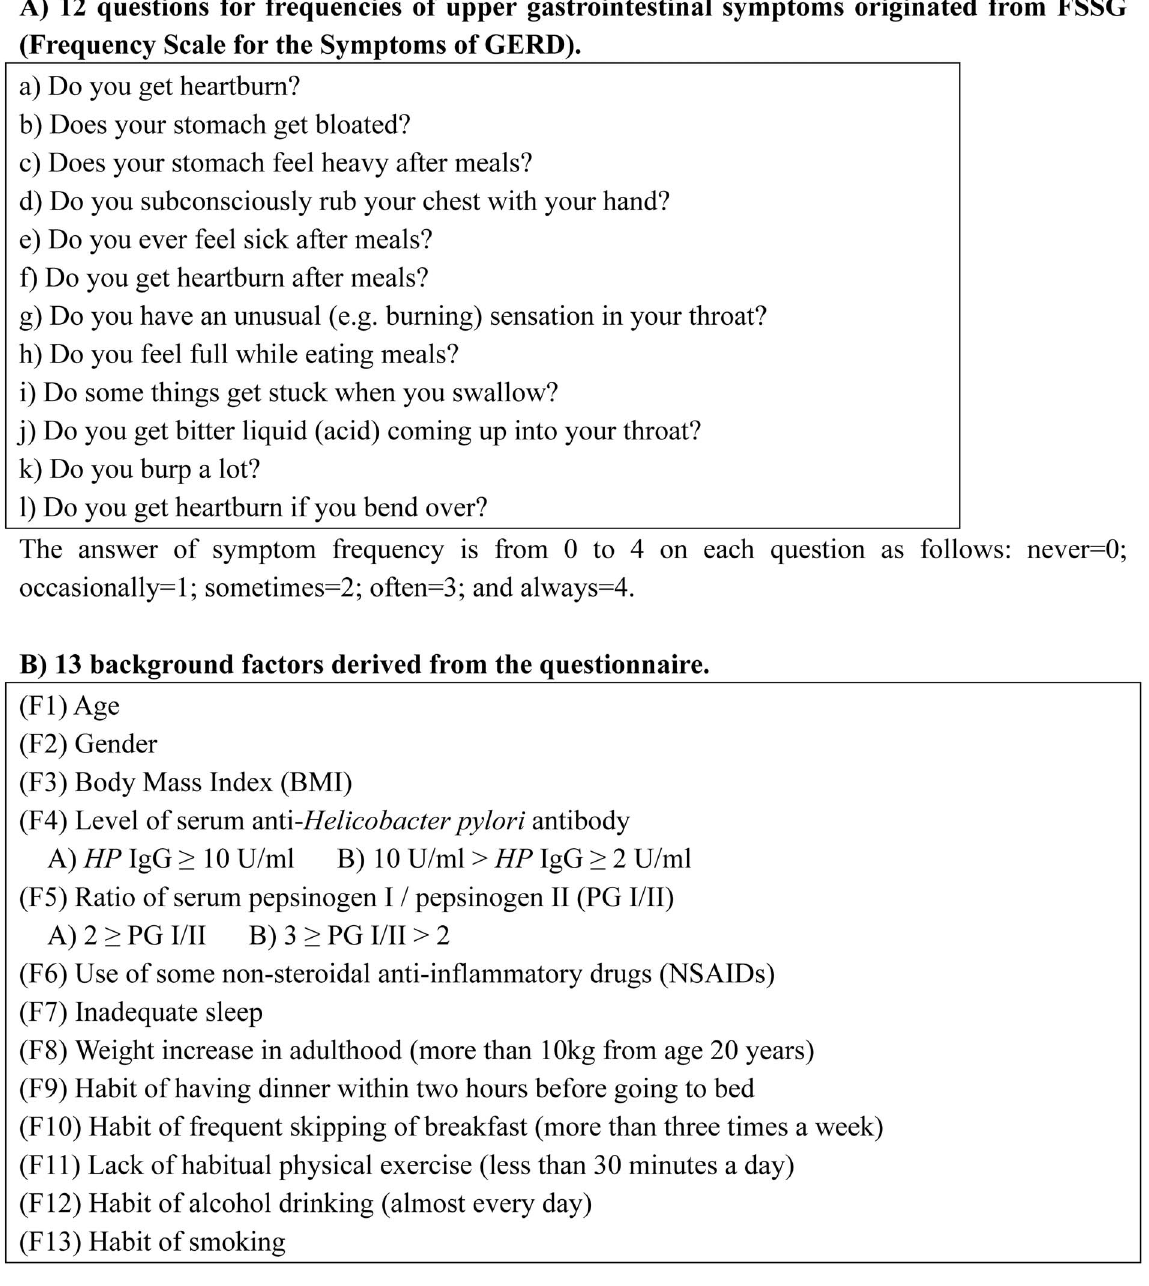
Figure 1. The 12 questions for frequencies of various upper gastrointestinal symptoms (A) and 13 background factors derived from the questionnaire (B).